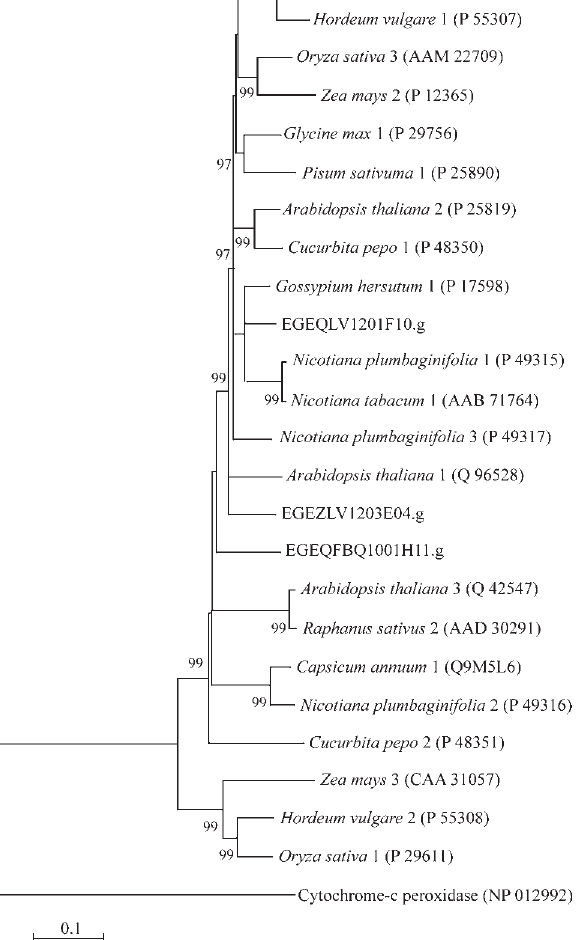
Figure 3 - Phylogenetic tree of CAT proteins. Phylogenetic analyses were conducted as described in Figure